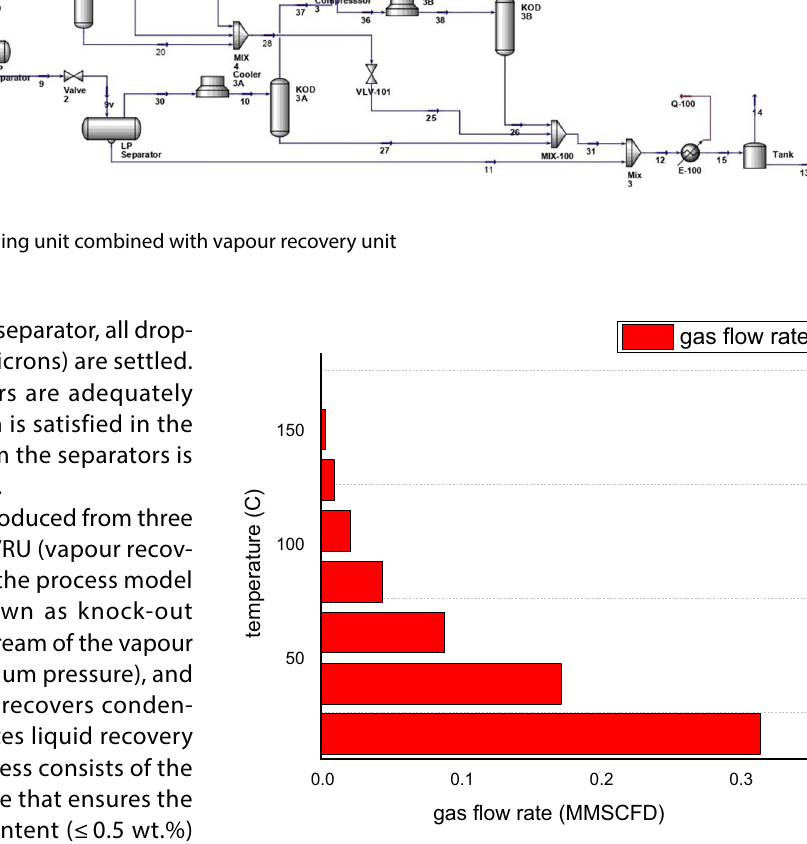
Fig. 4 Effect of temperature on vapour flow